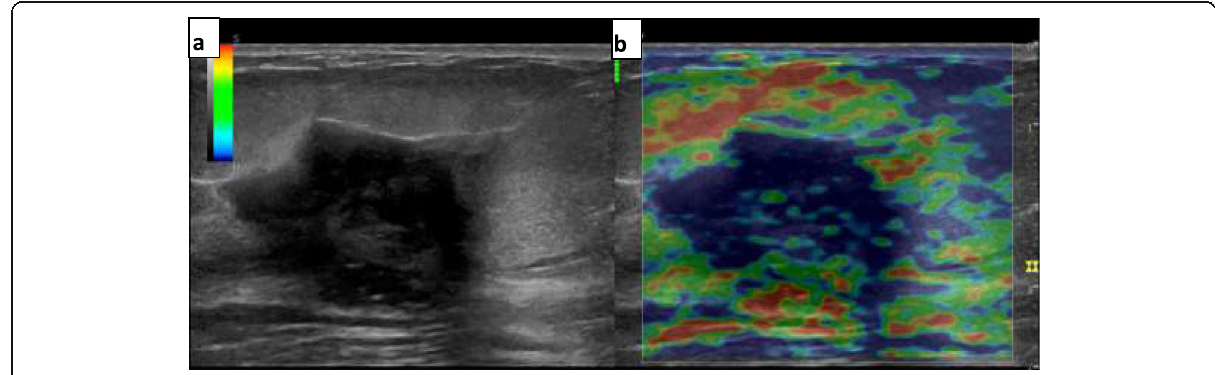
Fig. 1 A 53-year-old patient with Rt. breast mass proved to be invasive ductal carcinoma “ grade II ” on histopathological examination. Left , B- mode ultrasound showed ill-defined hypoechoic mass with irregular margins and few speculations was seen at 11 o ’ clock location, which is considered to be BIRADS 5 category. Right , strain elastography, the entire hypoechoic lesion was shaded in blue color with elasticity score (4), strain ratio =